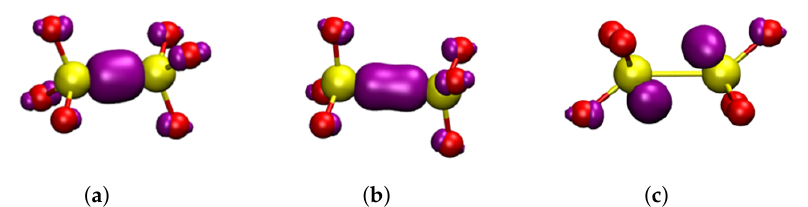
Figure 4. Square modulus of the wavefunction of the highest occupied state in the studied dimer oxygen defects in α -C shown in purple, the isosurface shown is | 0.1 | . Yellow atoms are silicon and red atoms are oxygen. ( a ) V 0 neutral dimer configuration. ( b ) E (cid:48) , positive dimer. ( c ) V − , negative O di O dimer. ( a – c ) are general HOMOs applicable to either α -cristobalite or α -quartz.